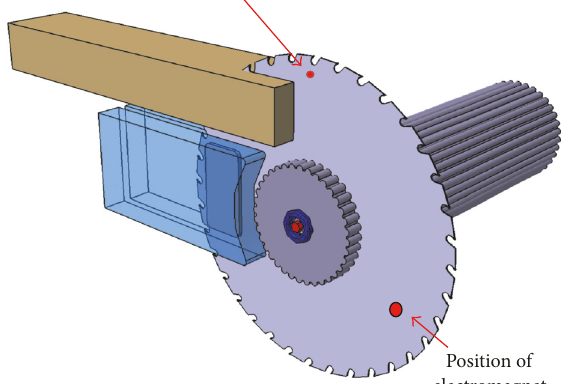
Figure 10: Schematic of the experimental setup.